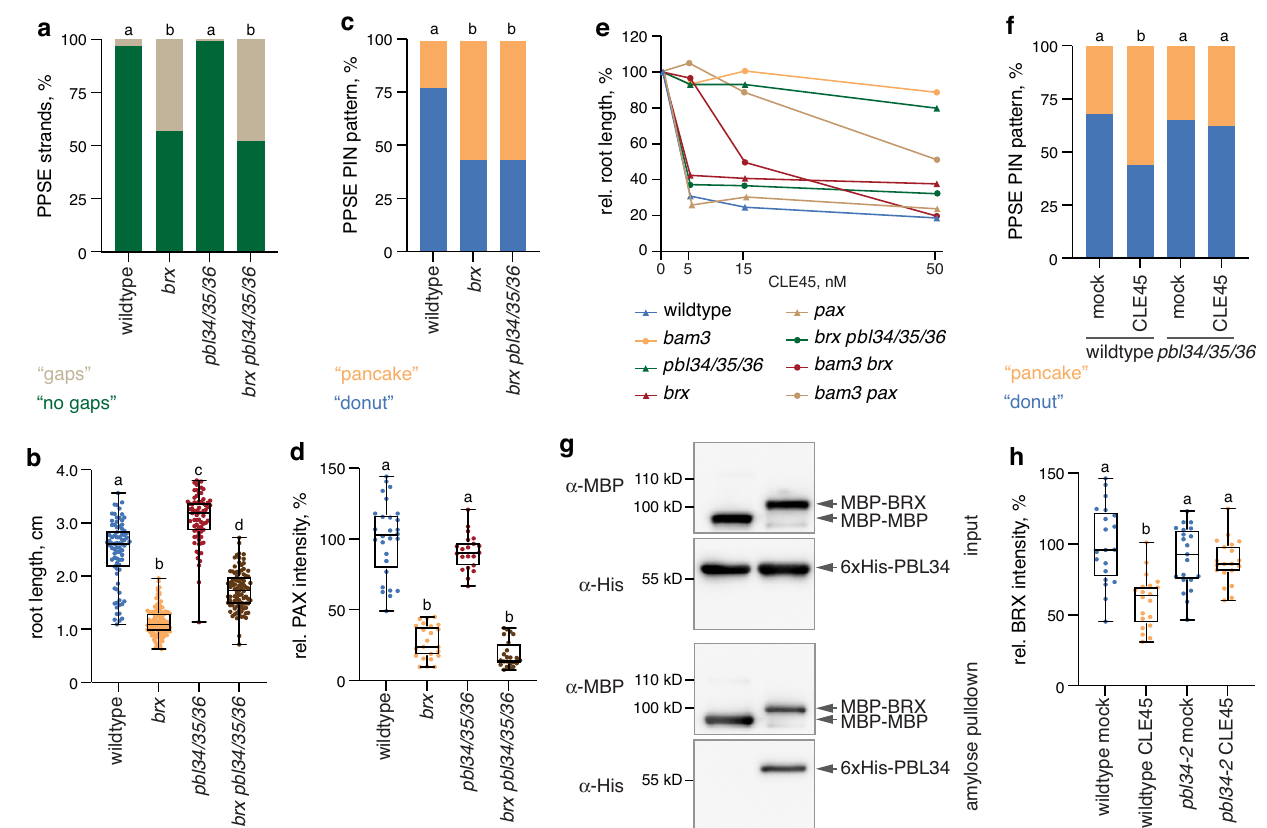
Fig. 4 | PBL34/35/36 areabranched output ofCLE45-BAM3 signaling. a Scoring of PPSE differentiation failures ( “ gaps ” ) in 7-day-old seedlings of indicated geno- types. n =59 – 162 PPSE strands; Statistically signi fi cant differences (lower case